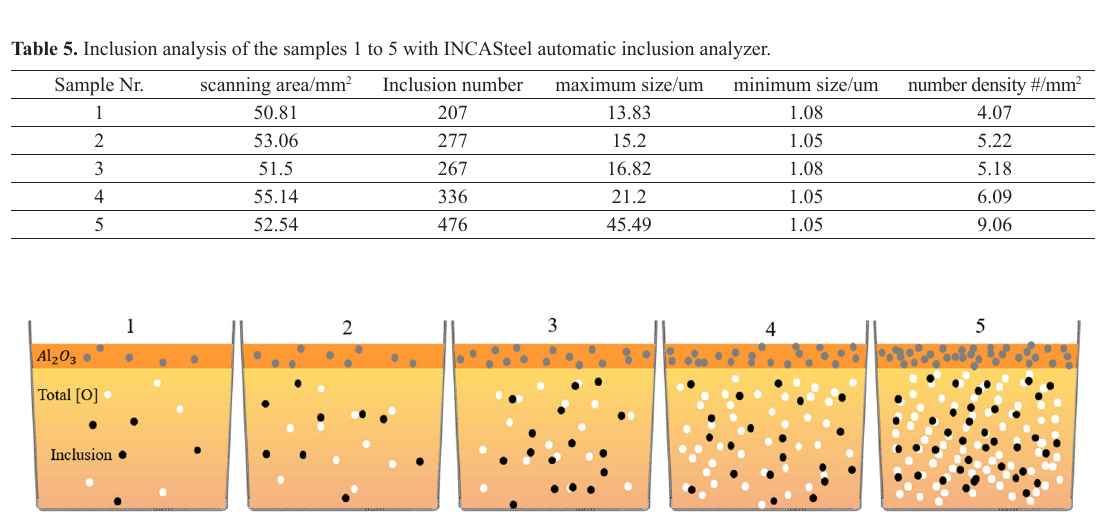
Figure 4. The schematic between the Al Al-killed ULC automotive